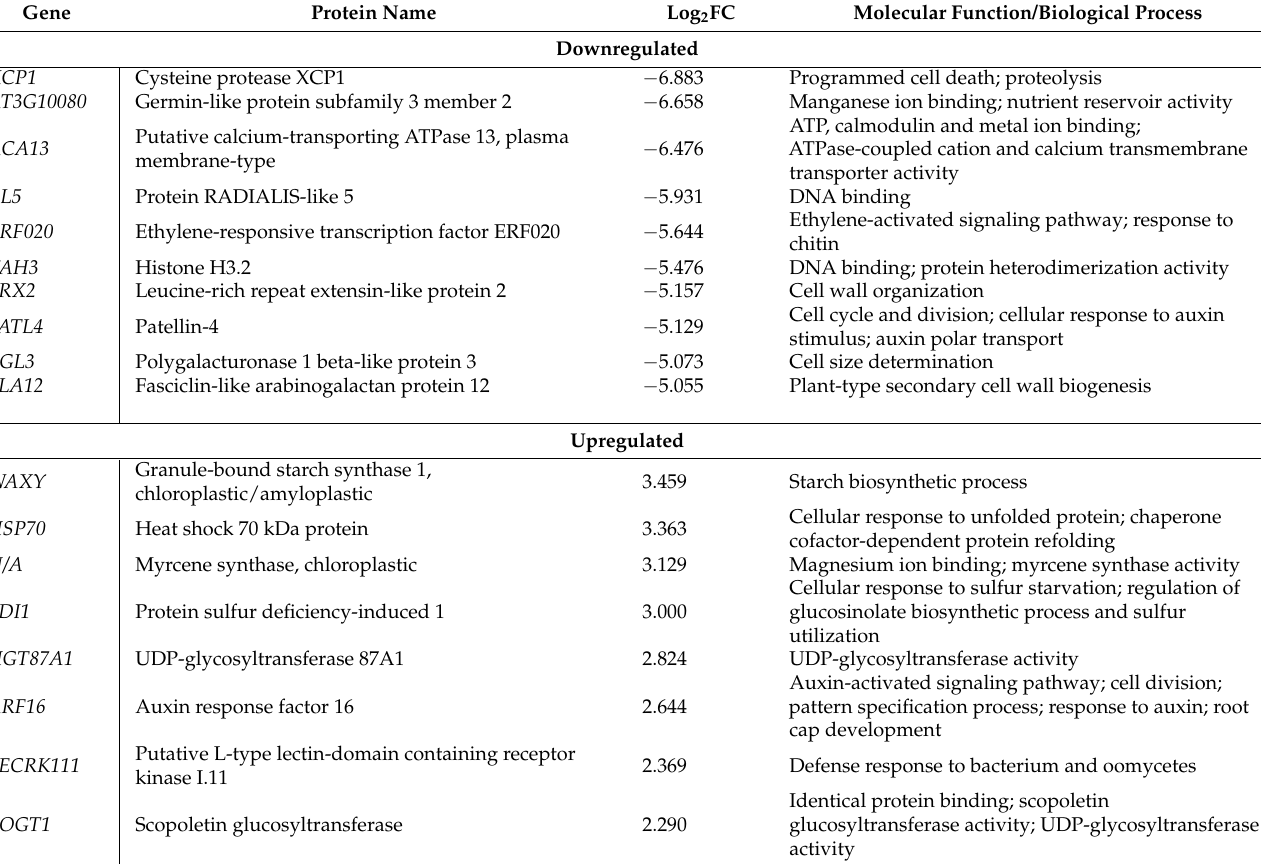
Table 2. Top 10 most down and upregulated differentially expressed genes (DEGs) in non-nodulated Casuarina glauca plants supplied with KNO 3 (KNO 3+ ), grown at 400 mM NaCl relative to the control (0 mM NaCl), ordered by log2 fold-change (log2FC). NBCI gene symbol, protein name, log2FC and respective Gene Ontology (GO) molecular function(s) and biological process(es) were retrieved from UniprotKB database. Protein names coloured in blue are also among the top 10 most down or upregulated DEGs, respectively, at 400 mM NaCl in plants nodulated by nitrogen-fixing Frankia casuarinae Thr (NOD +